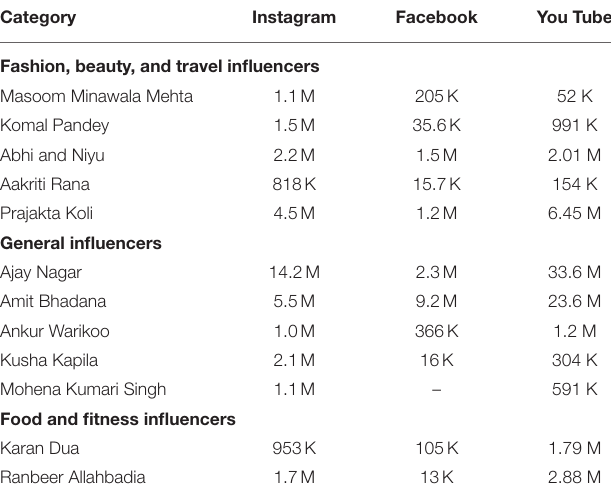
TABLE 1 | Numbers of followers of Indian social media